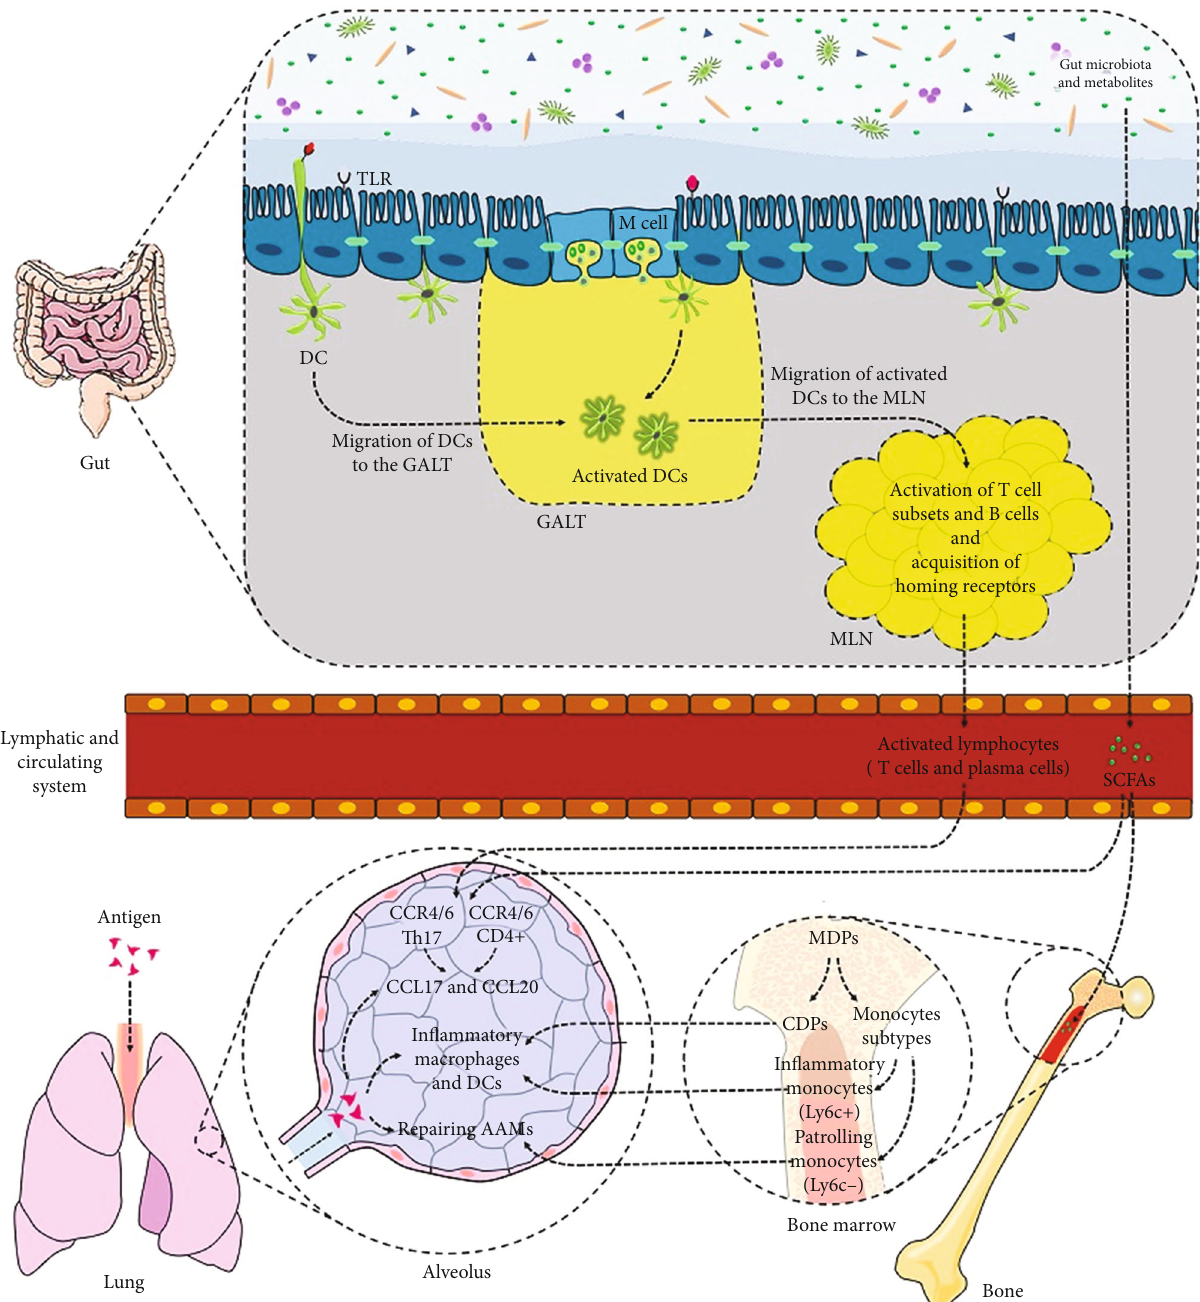
Figure 1: Relationship between the gut microbiota and lung immunity: the interaction between the intestinal commensal bacteria and establishing of lung immunity is mediated by various factors, including PAMPs, PRRs, SCFAs, intestinal integrity, and immune cells of the lamina propria. In a normal state, DCs are continuously sampled from the lumen through M-cell activity, extension of dendrites, and the gut barrier function, which determine bacterial/PAMP translocation. After DC sampling, these cells migrate to GALT and then MLN to regulate di ff erentiation and homing of lymphocytes (T and B cells) depending on the released certain cytokines in respect to gut microbiota composition. The activated T and B cells are distributed in the lungs via circulation. Also, the levels of CCL20 and CCL17, which are produced by the lungs after microbial exposure, contribute to imprinting of T cell subsets, based on the cognate CCRs. Furthermore, SCFAs can penetrate into the bone marrow and in fl uence lung immunity by a ff ecting MDP di ff erentiation to in fl ammatory or anti-in fl ammatory immune cells. In fl ammatory macrophages and DCs in the lungs are derived from CDPs and Ly6C + in fl ammatory monocytes. Alternatively, activated macrophages (AAMs) are anti-in fl ammatory immune lung cells, derived from Ly6C - patrolling monocytes